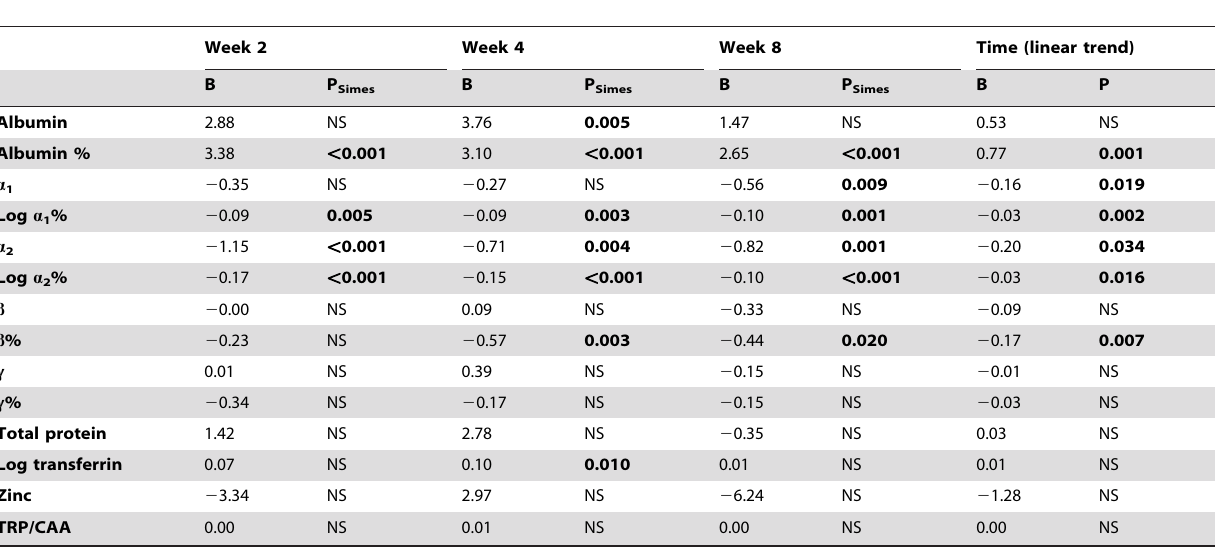
Table 5. Effects of anti-TNF- a infusion on immune parameters and TRP/CAA compared to baseline reference